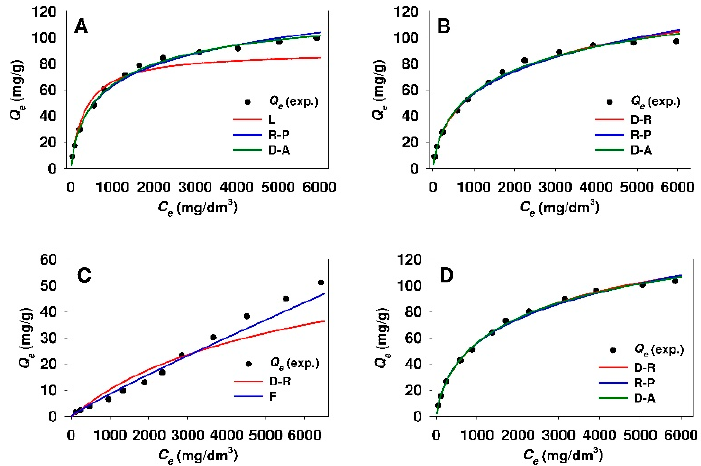
Figure 11. Comparison of experimental and predicted isotherms of 18 β -glycyrrhetinic acid adsorption onto ( A ) Aer-AP, ( B ) Aer-MAP, ( C ) Aer-DMAP, and ( D ) Aer-AEAP adsorbents. The best fitted isotherm models derived from linear analysis are presented. Isotherm models: F, Freundlich; D-A, Dubinin-Astakhov; D-R, Dubinin-Radushkevich; L, Langmuir; R-P, Redlich-Peterson.